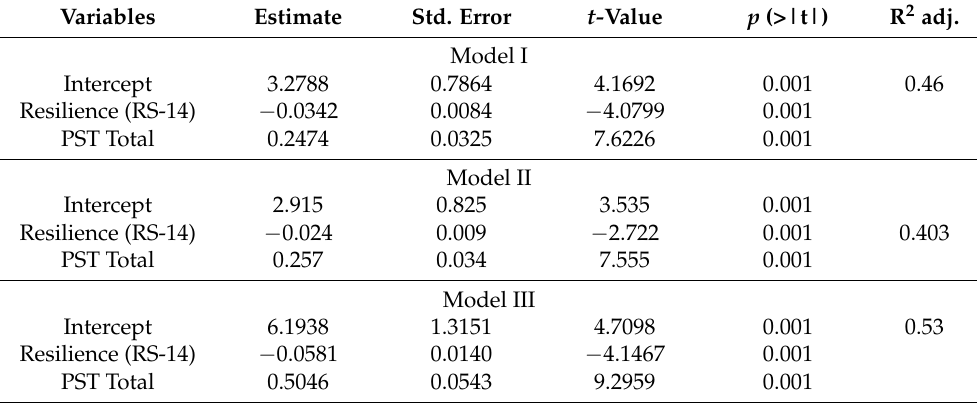
Table 3. Parameters estimated for model 1 depression as dependent variable, model II anxiety as dependent variable and model III psychological distress as dependent